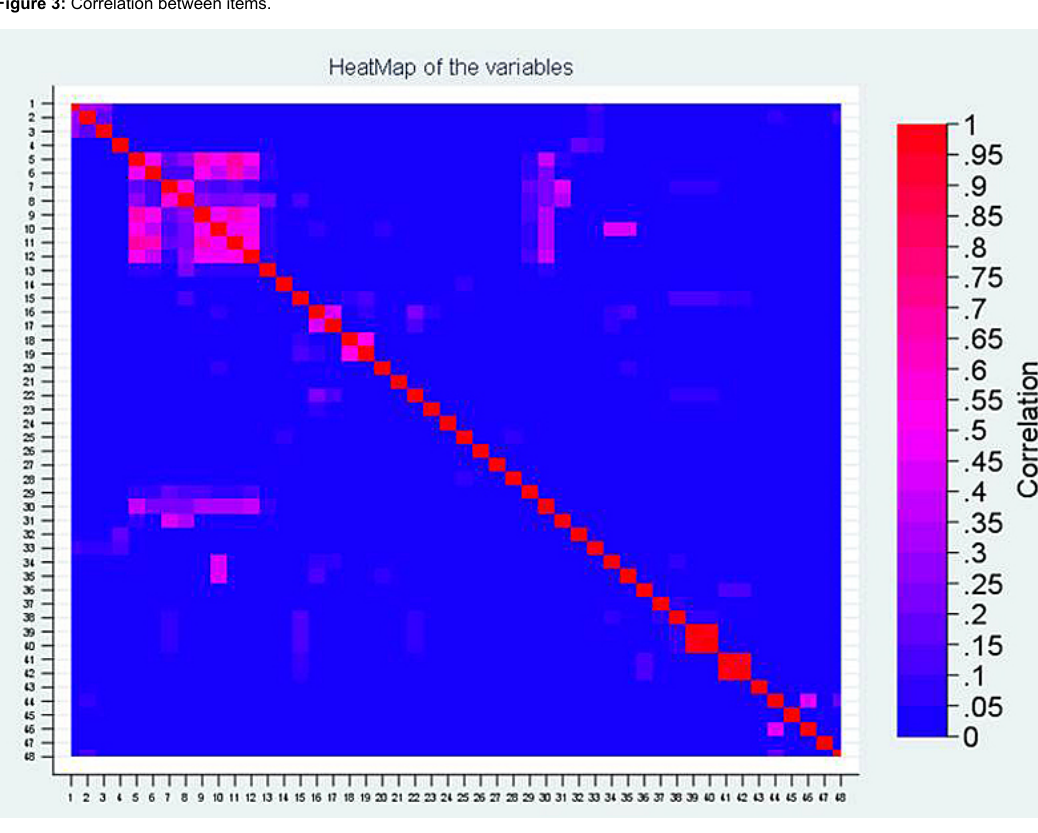
Figure 3: Correlation between items.